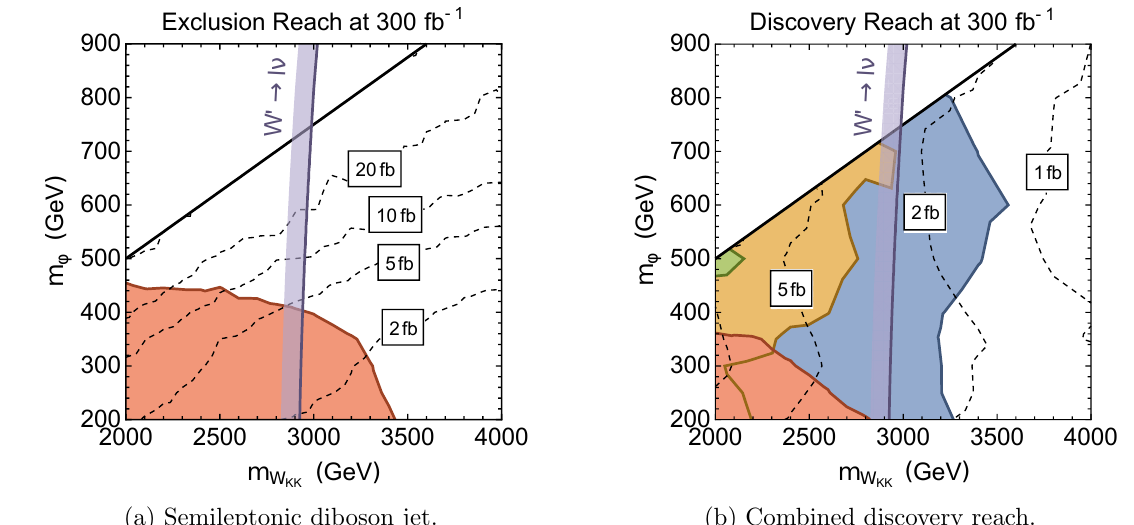
Figure 12. Left: exclusion reach with = 300 fb (cid:0) 1 for a semi-leptonic diboson jet recoiling against L a hadronic W jet. Right: combined discovery reach with = 300 fb (cid:0) 1 . Red: qq ( ‘(cid:23)qq ), orange: L ‘(cid:23) ( qqqq ), green: qq ( qqqq ), blue: combination. Dashed contours indicate the exclusion or combined discovery cross section for W KK W’ W ( WW ). The purple line indicates the current exclusion ! ! due to the search for W 0 ‘(cid:23) of ref. !